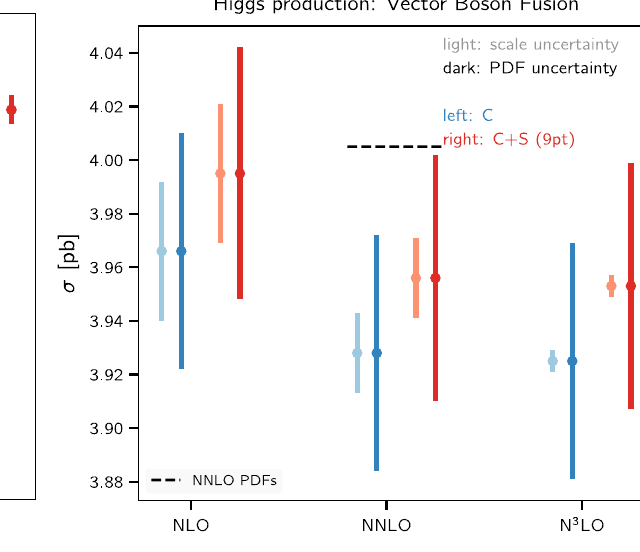
point prescription). The light-shaded bands represent the uncertainty on the hard cross-section (“scale uncertainty”) evaluated using the theory covariance matrix (see text) the dark bands represent the PDF uncer- tainty. For the NNLO result, we also show the central value obtained using NNLO PDFs as a dashed horizontal